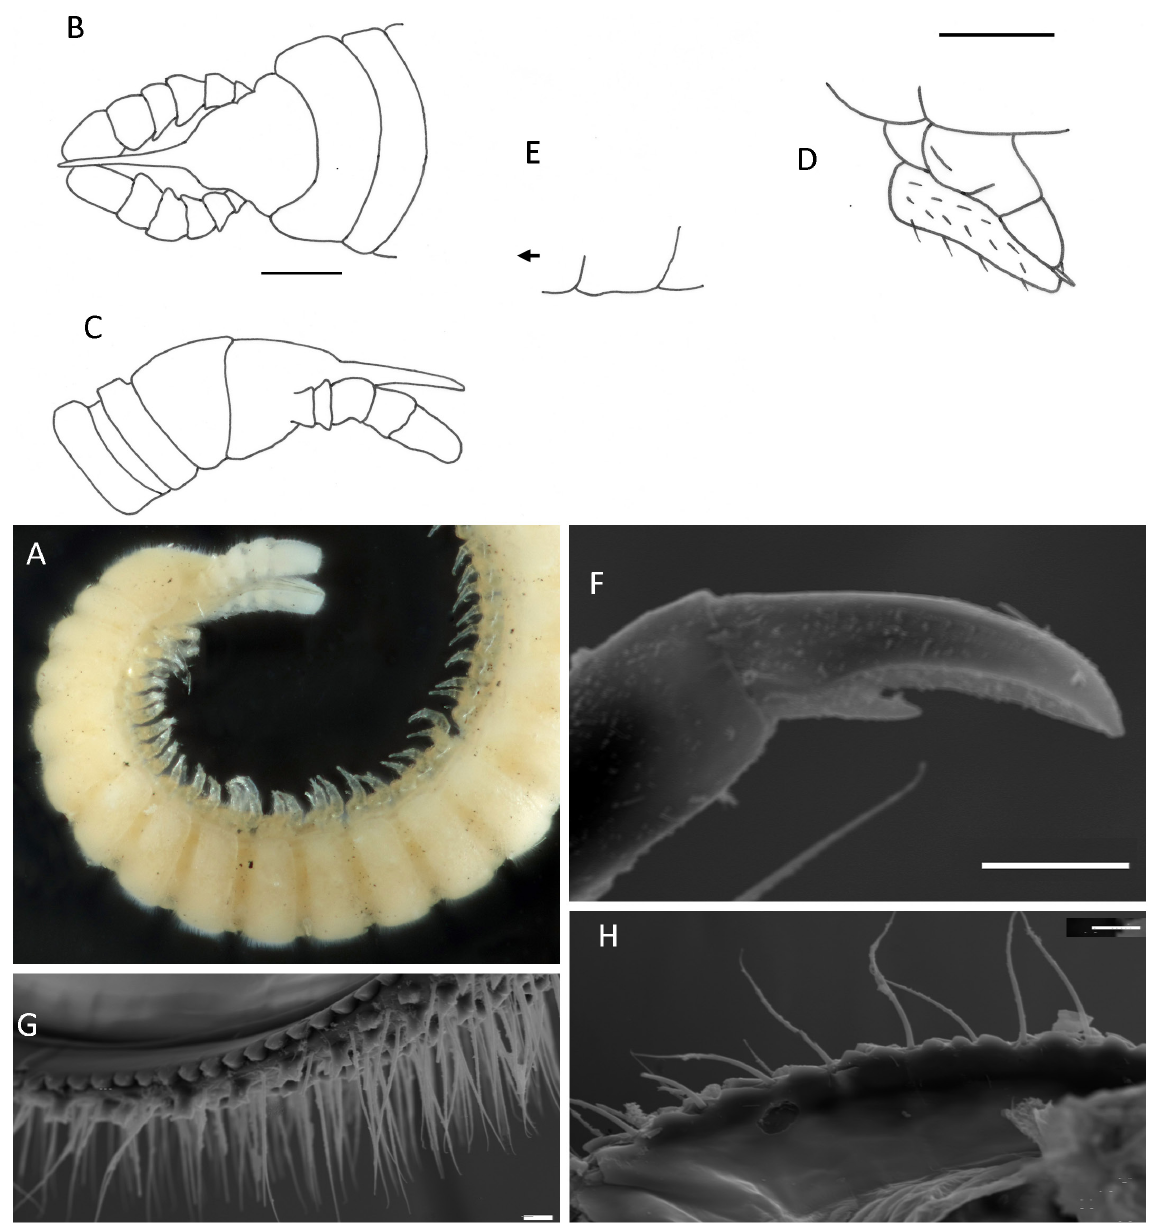
Fig. 2. Siphonophora hebetunguis (Attems, 1951), type specimen (NHMW 2295). A . Head and anterior rings, body width approximately 0.8 mm. B . Head in dorsal view. C . Head in lateral view. D . Male gonopods. E . Ventral margin of pleurite in lateral view, anterior to left. F . Claw. G . Mid-body limbus of male. H . Mid-body pleurite hind edge from inside (male). Scale bars: A = 800 µm; B–E = 200 µm; F–H = 10